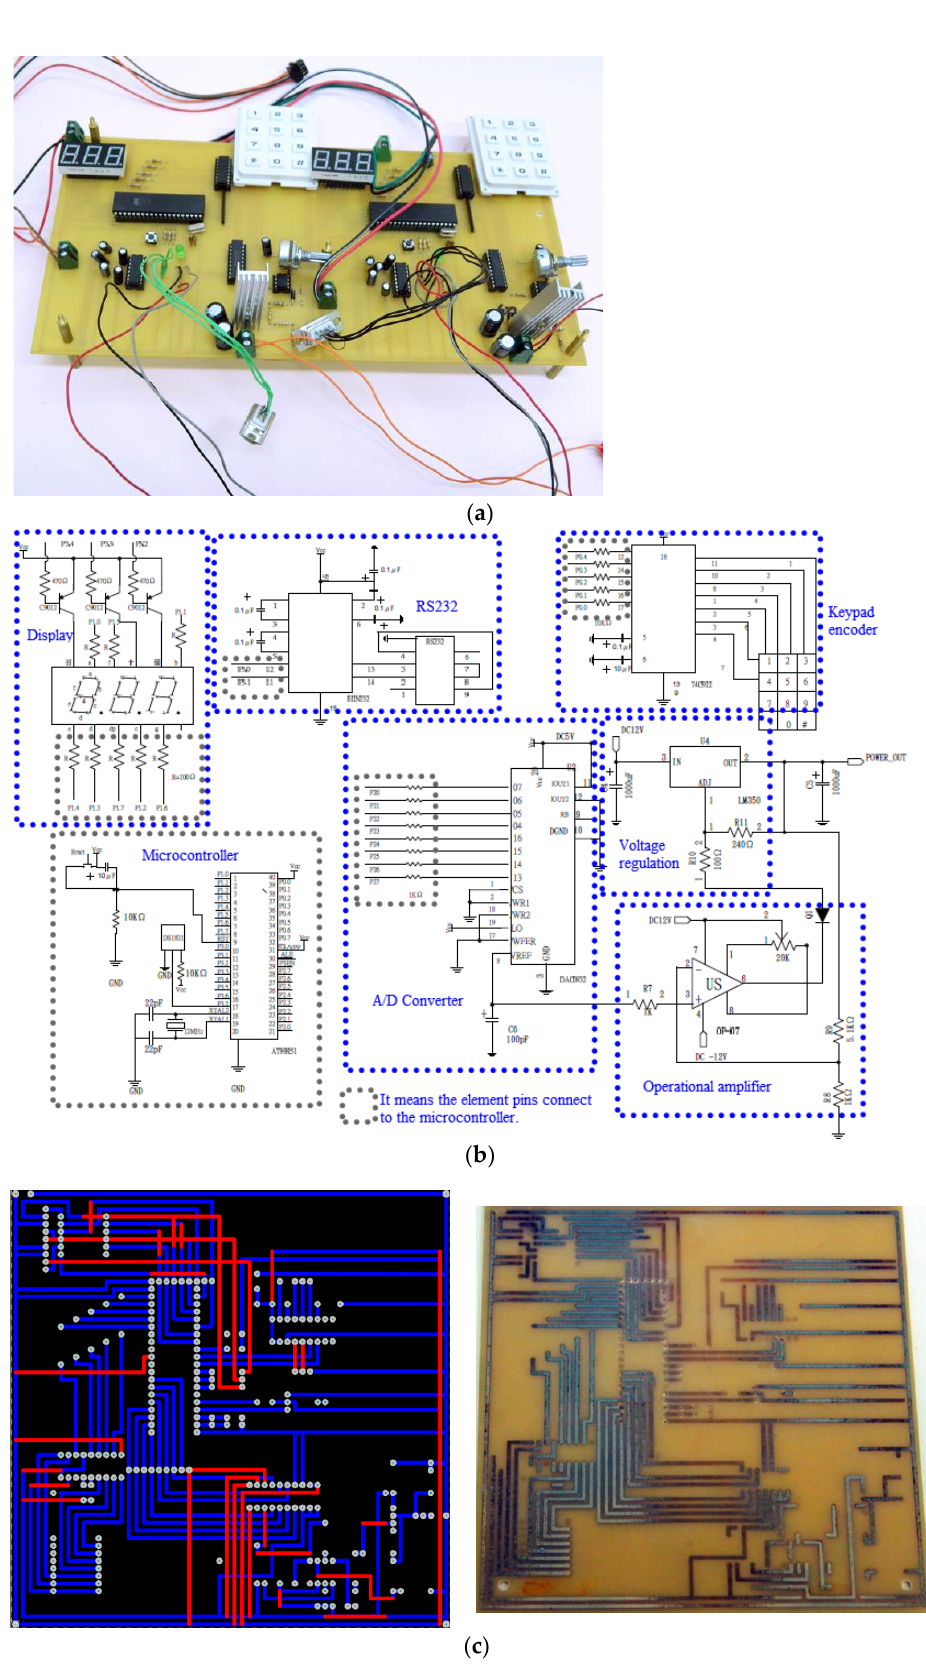
Figure 2. ( a ) The photograph of the homemade thermal control module. ( b ) The circuit diagram. ( c ) The schematic diagram and the photograph of the homemade PCB.